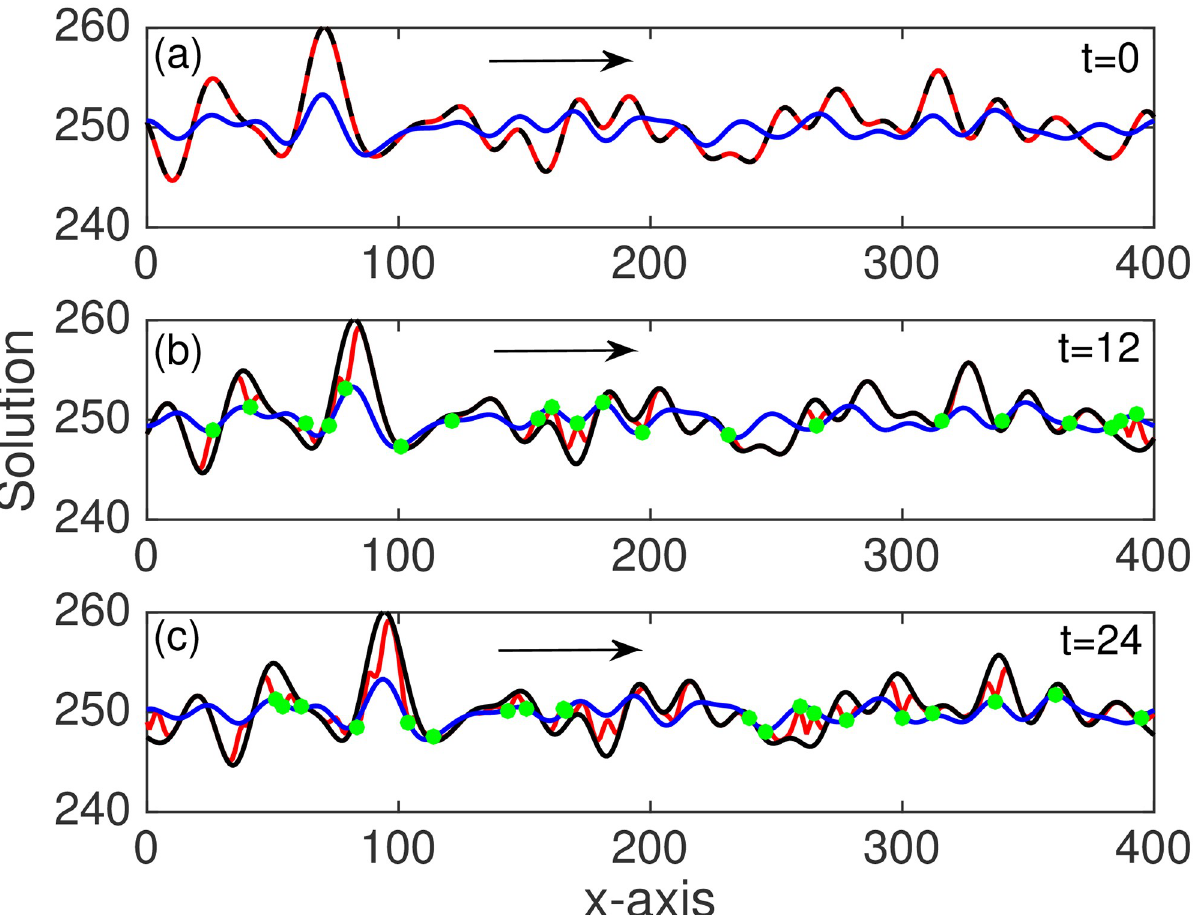
Fig 5. Experiment 3. The state vector solution from the truth run (blue), the no assimilation run (black), and the Kullback-Leibler data assimilation solution (red). Shown at (a) the initial condition (t = 0), (b) the time of first observations (t = 12), and (c) the time of second observations (t = 24). The observations (green circles) are taken at random locations and include random measurement error. The arrow indicates the direction of the advected flow.